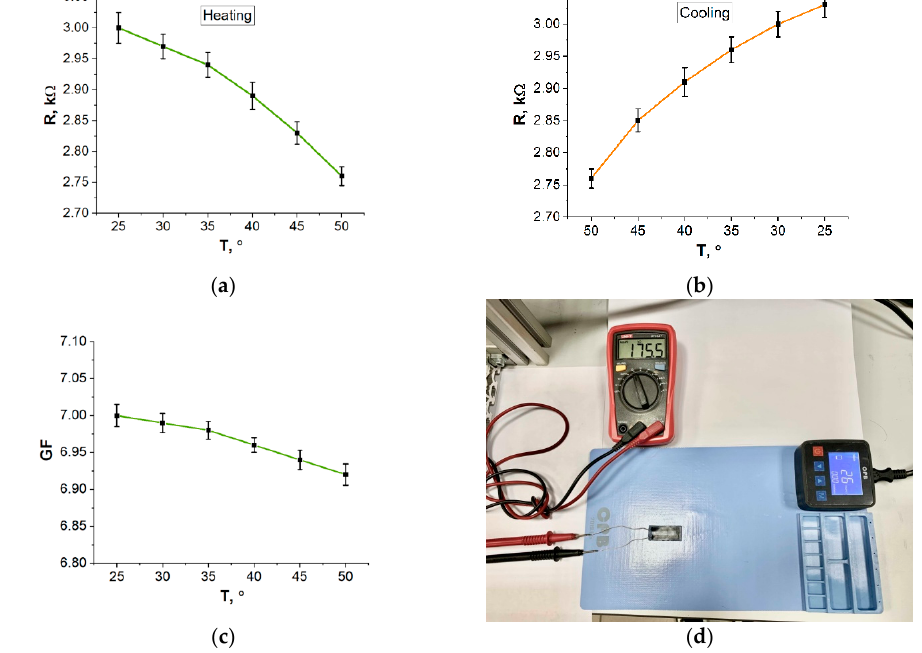
Figure 9. Temperature dependence of resistance ( a ) while heating, ( b ) while cooling, ( c ) GF dependence of temperature, ( d ) measurement of the change in resistance during heating.